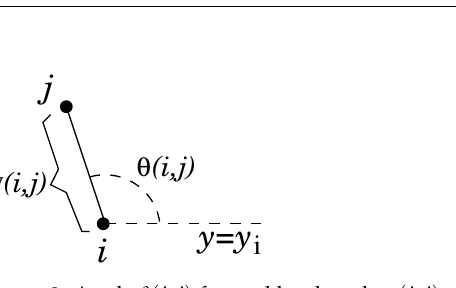
Figure 2. Angle θ ( i , j ) formed by the edge ( i , j ) and the straight line y = y i .